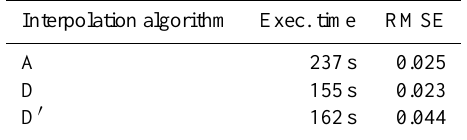
Table 3. Execution time and RMSE for experiments made with the ‘peaked’ diffusivity distribution, varying interpolation method and ∆ t selection algorithm.